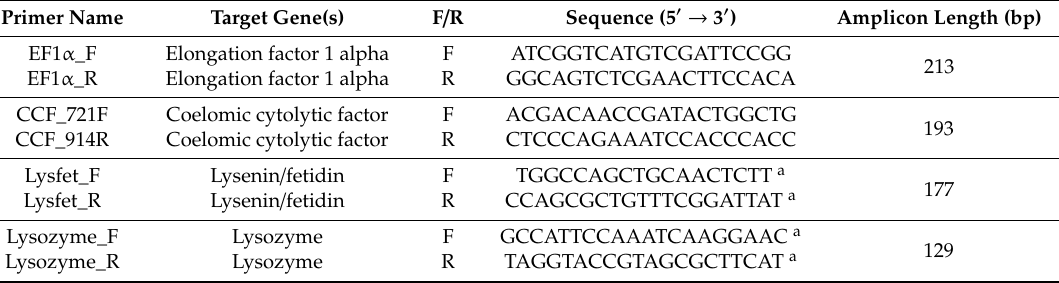
Table 1. Details of primers targeting housekeeping gene (EF1 α ) and target immune system genes.